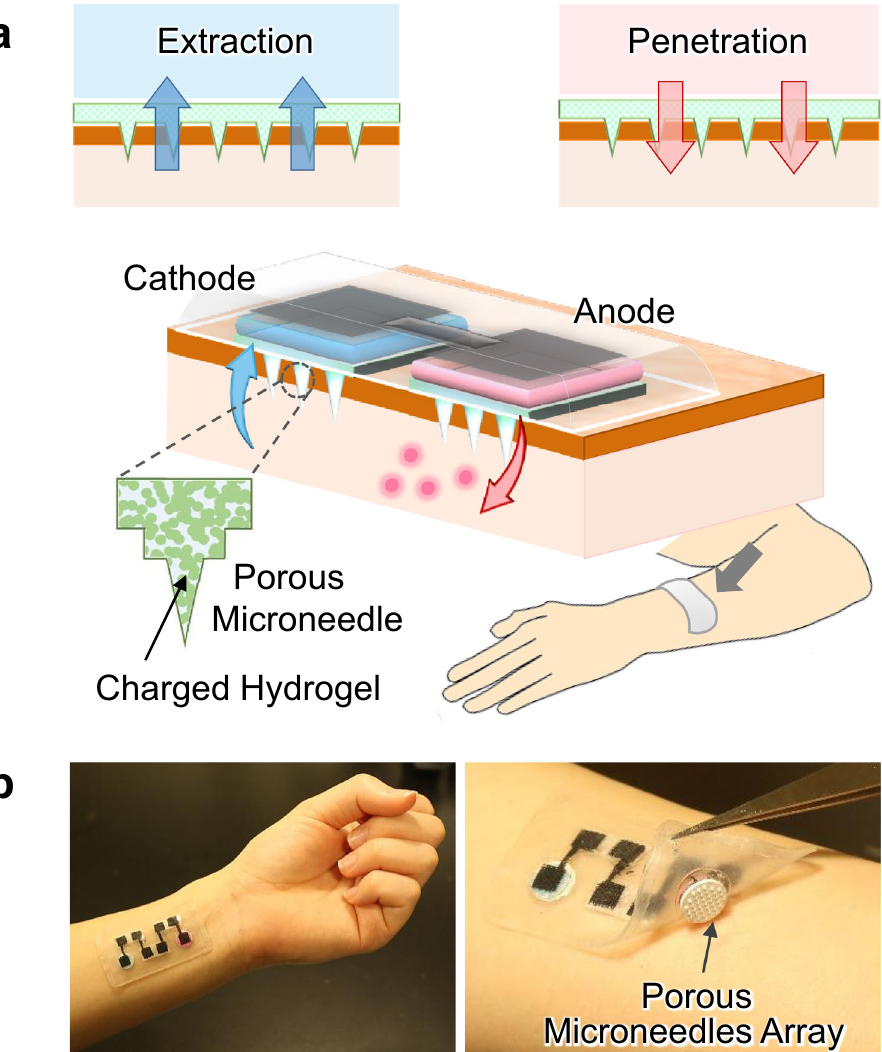
Fig. 1 Transdermal electroosmosis by a porous microneedle array patch. a Conceptual illustration of the electroosmotic penetration/extraction for ef fi cient drug delivery and analysis of ISF. The fl ow direction from anode to cathode is the case when the porous microneedles are modi fi ed with a negatively charged hydrogel. b Photographs depict a structural overview of the combination of the biobattery (four cells connected in series) and the porous